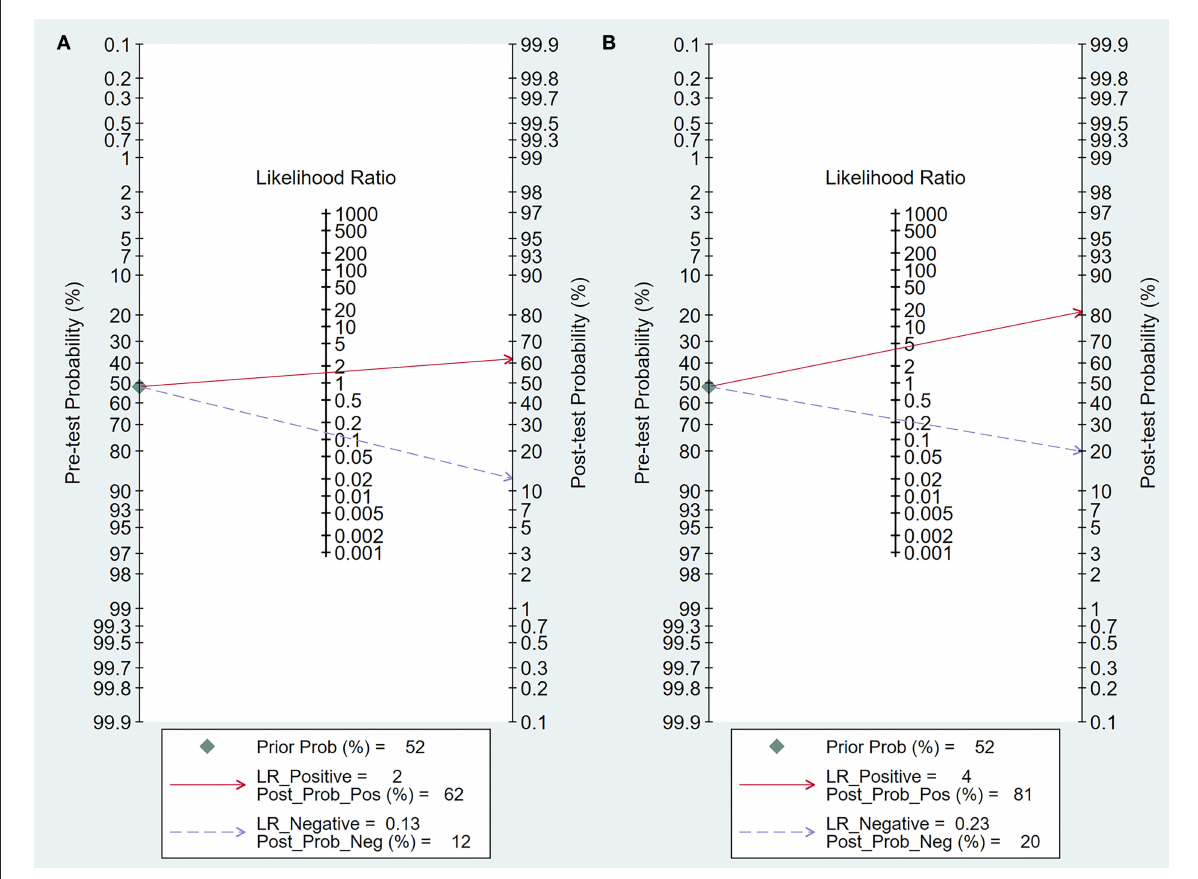
FIGURE5 Fagan’s plot of post-test probability. (A) Fagan’s plot of intraoperative BAEP change group; (B) Fagan’s plot of intraoperative BAEP loss